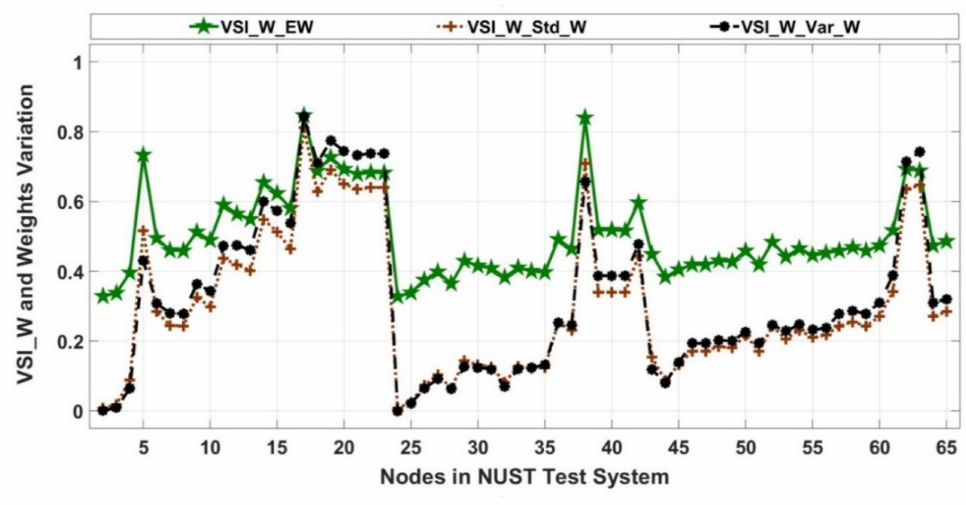
Figure 19. Weighted VSI_W with equally biased weights in the 65-bus MCMG under NL. The weights allocated in equal proportions (w = 0.333 for each VSI ) for initial evalu- ation were kept equal for VSI_W with respect to Equation (4) in Figure 18. The weights in VSI_W were also allocated on the basis of biased weight variations in terms of stan- dard deviation and variance trends to find the sensitivity analysis of change of potential buses/nodes, as shown in Figure 19. The respective sitting sites for DGs and asset set (REG-D-STATCOM) across VSI_A , VSI_B , and VSI_W are shown as